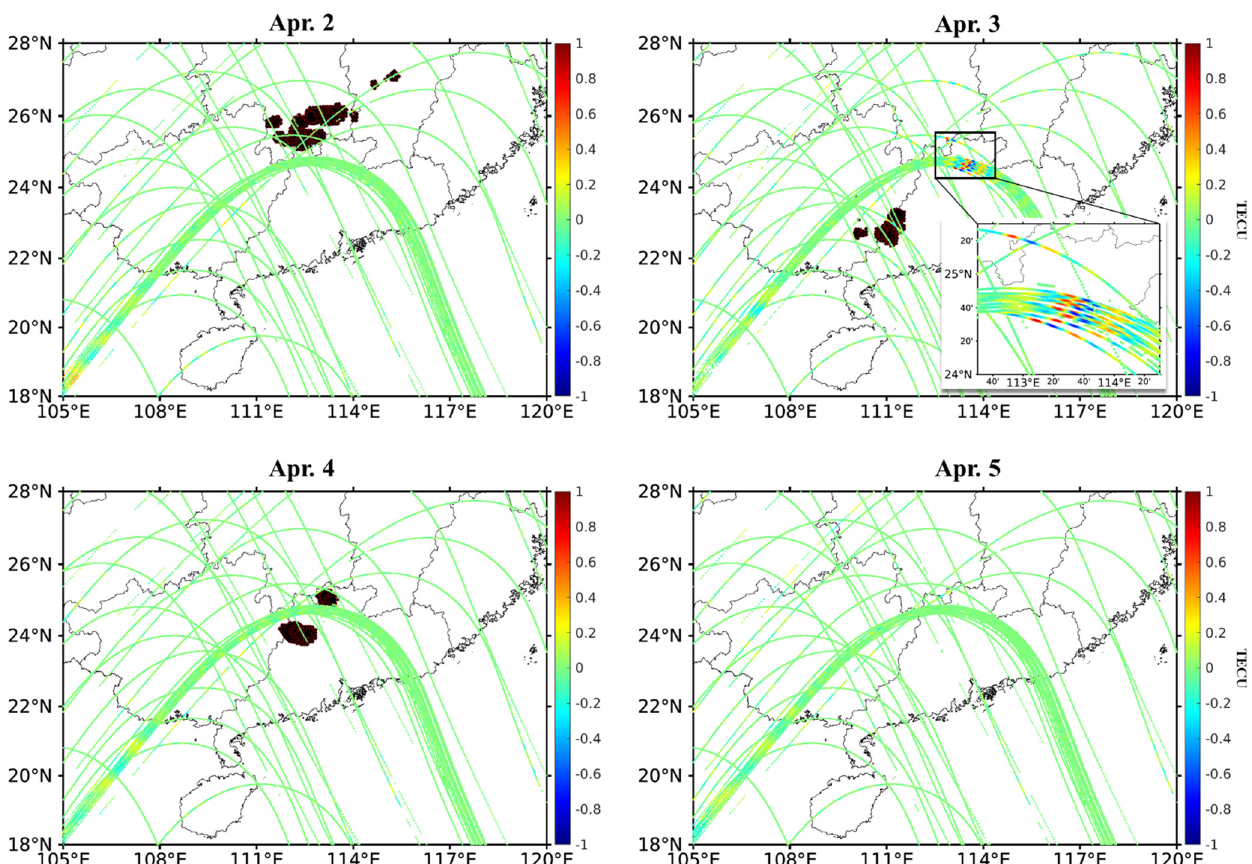
Figure 3. GW observations extracted from stations at low latitudes in China on 2–5 April 2019. The universal time is 10–16 h, i.e., 18–24 h local time. Different curves indicate the ionospheric penetration point trajectories of PRN2 observed by different base stations; the color axis indicates the amplitude of ionospheric GWs in TECU. Black patches show thunderstorm areas.